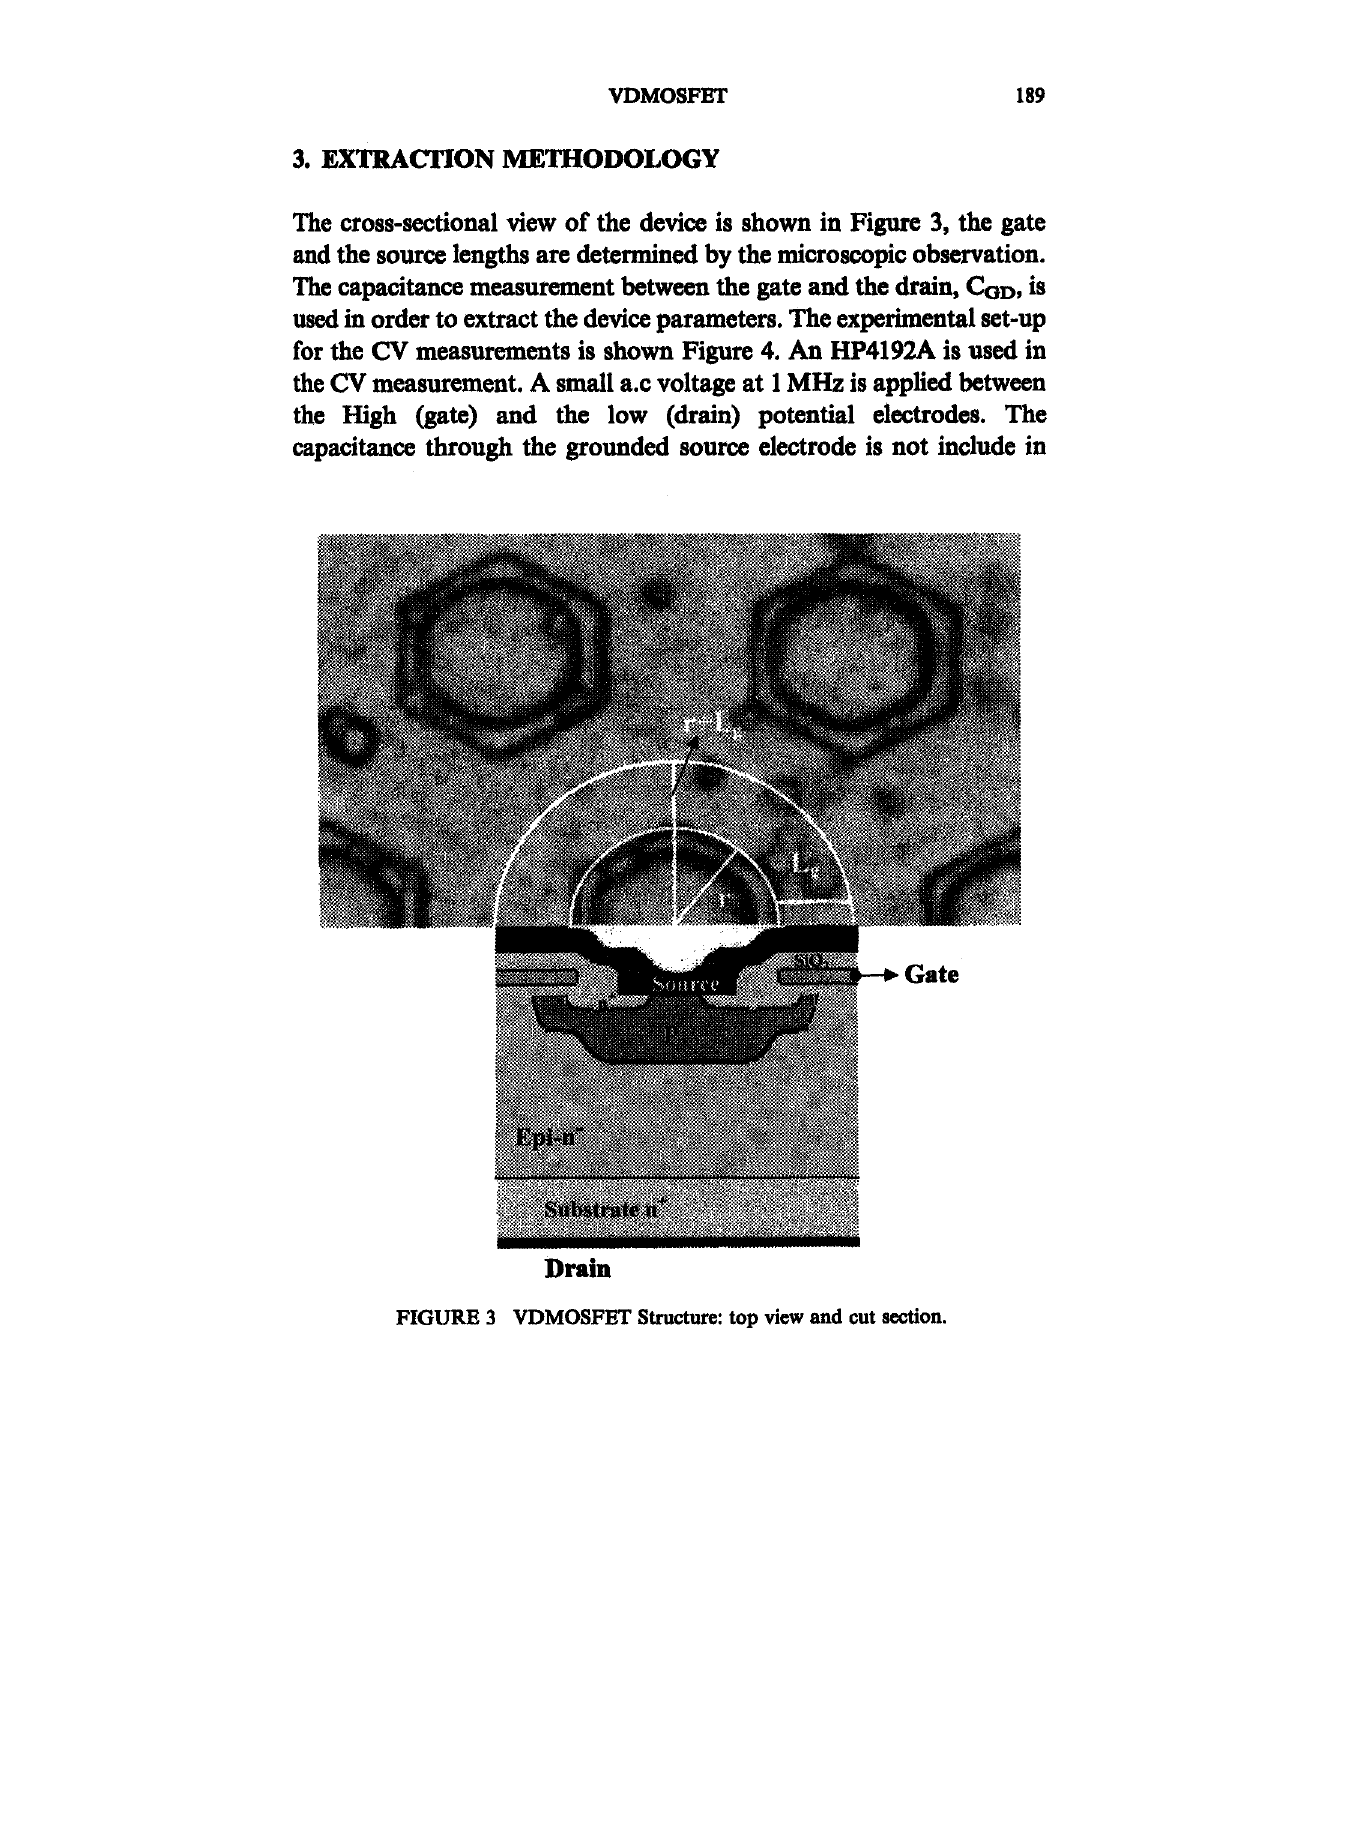
FIGURE 3 VDMOSFET Structure: top view and cut